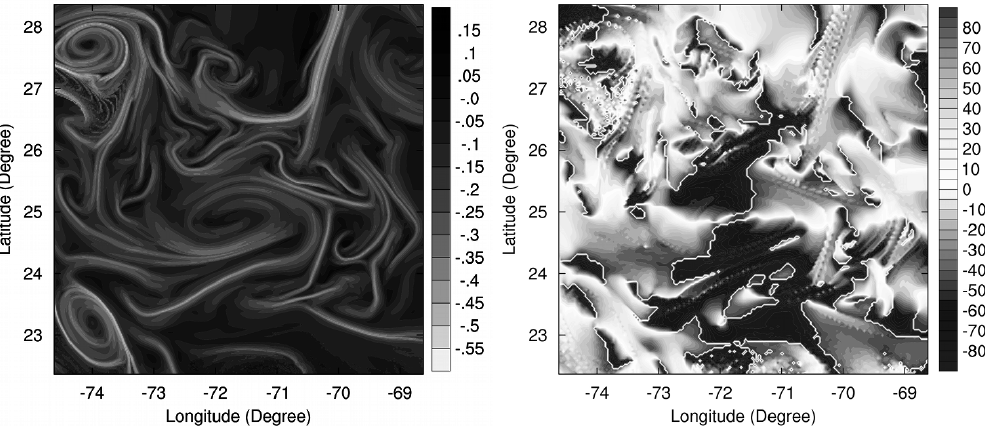
Figure 9. Backward FTLE (day − 1 ) (left panel) and corresponding backward FTLV orientations (angular degree) (right panel) computed from the surface velocity of a simulation of the North Atlantic